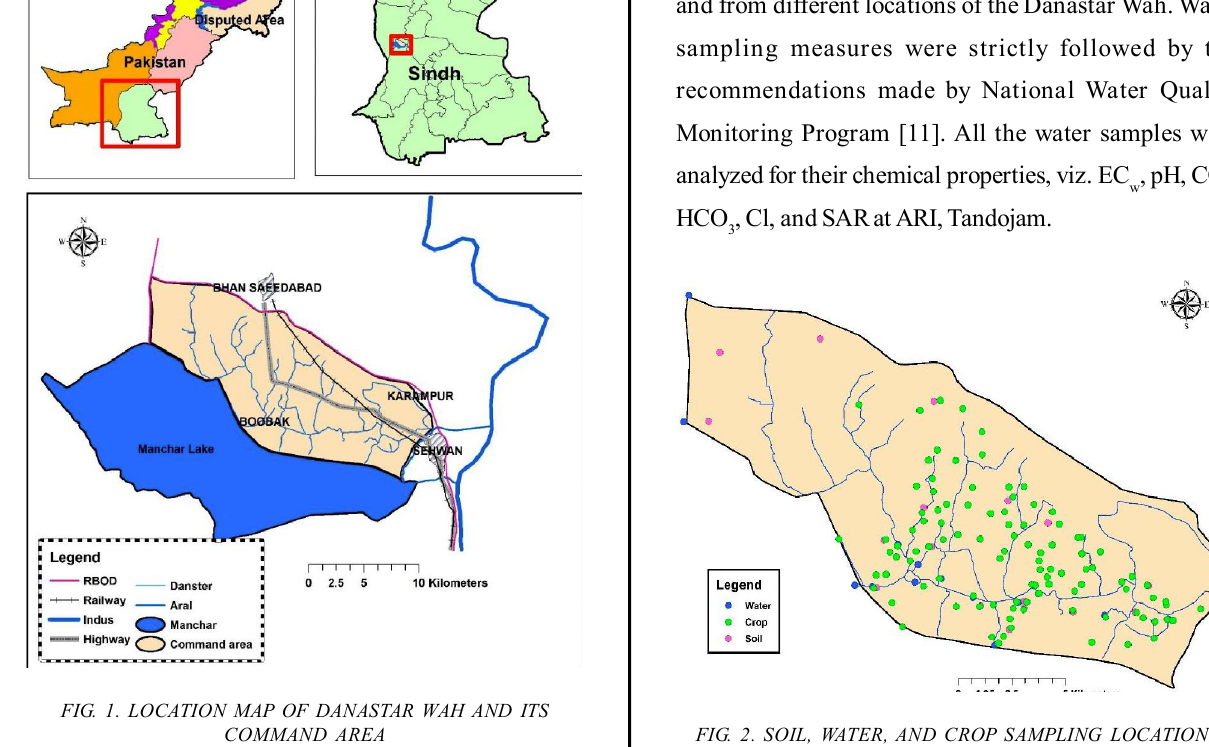
FIG. 1. LOCATION MAP OF DANASTAR WAH AND ITS COMMAND AREA FIG. 2. SOIL, WATER, AND CROP SAMPLING